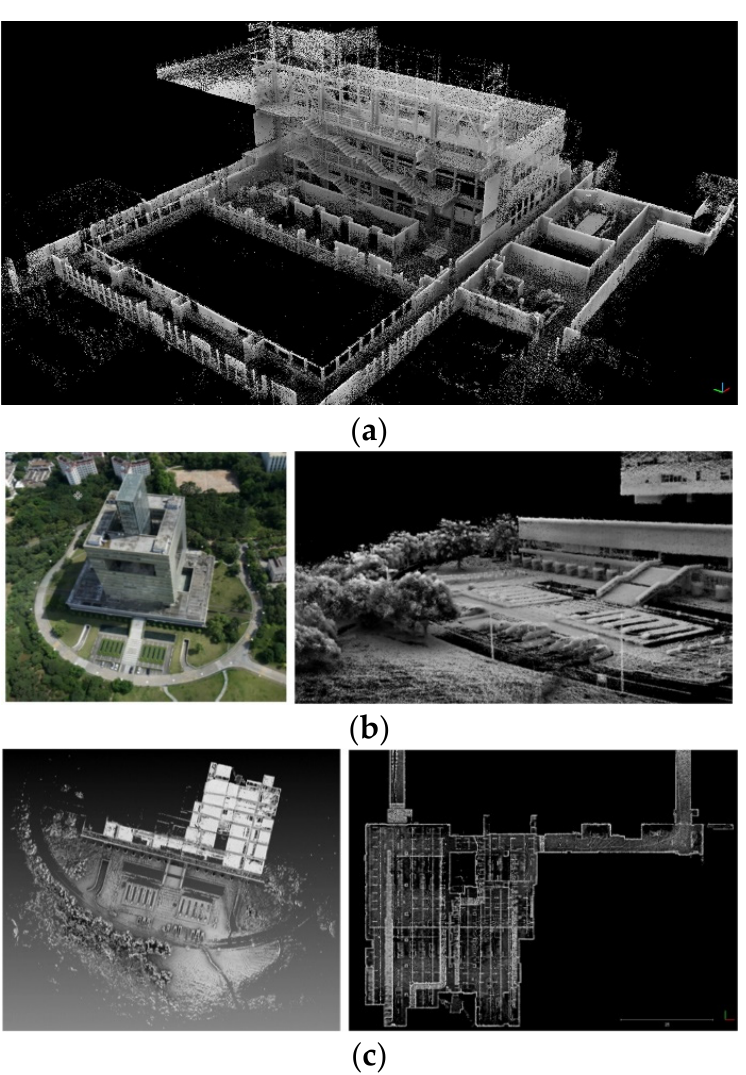
Figure 6. Experimental scenes. ( a ) The indoor scene. ( b ) The outdoor scene. ( c ) The indoor-outdoor integrated scene.